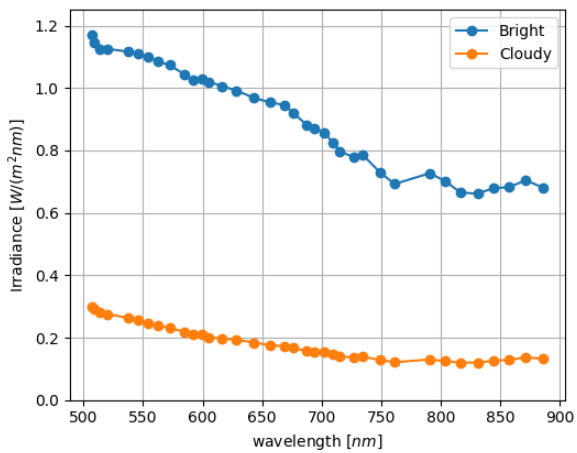
Figure 7. Spectral irradiance measured with FGI AIRS for data cubes collected in bright and cloudy illumination conditions. Line markers show centre wavelength for FPI bands.